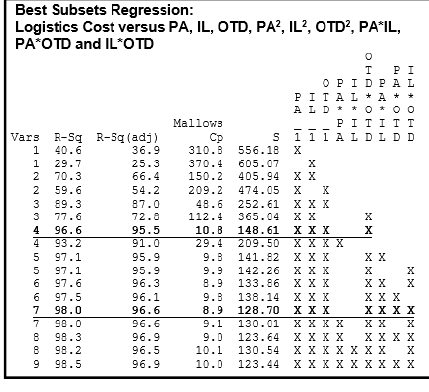
Figure 8. Subsets Regression Four Predictors Subset.